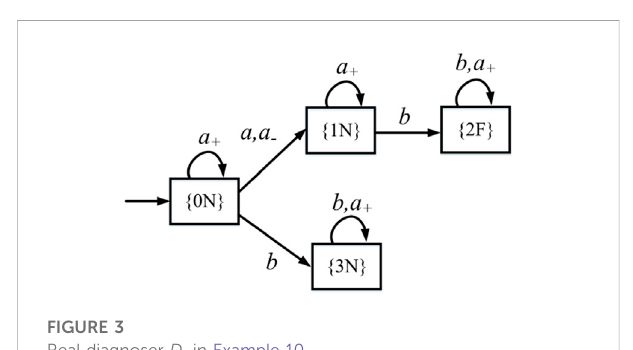
FIGURE 3 Real diagnoser D r in Example